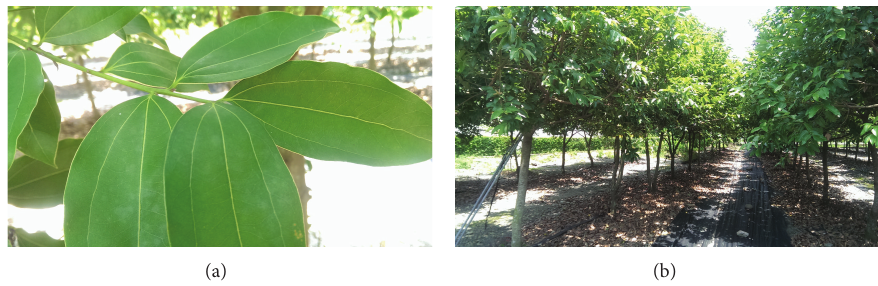
Figure 1: The photos of Cinnamomum osmophloeum Kanehira. (a) Leaves. (b) A whole